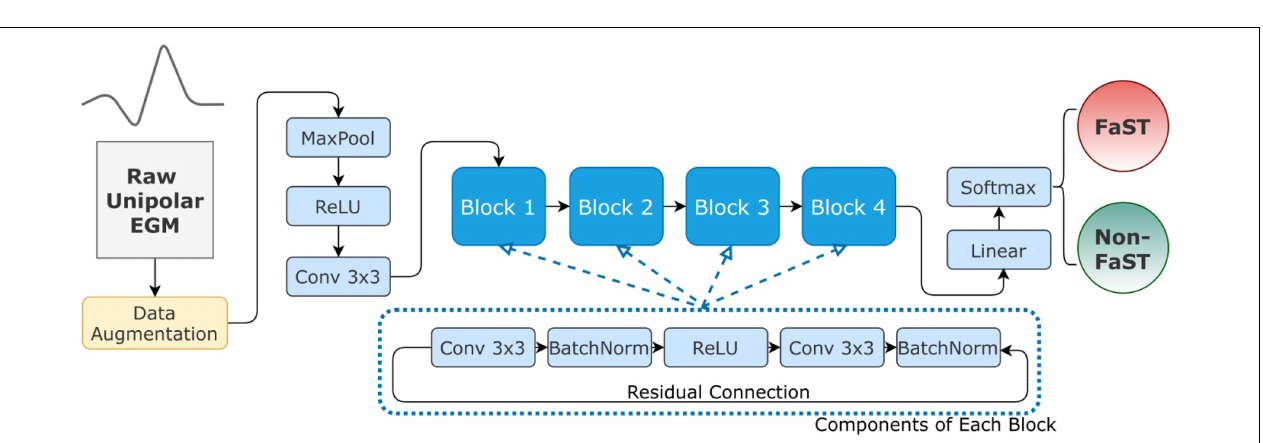
FIGURE 2 | Convolutional Neural Network Architecture. The DL model inputs raw unipolar EGM (right) and outputs a binary decision as FaST vs. non-FaST (left) . For robust training, the raw inputs are normalized and augmented as described in the text. The architecture of the proposed network is inherited from ResNet-18, which has 4 residual blocks. Each block consists of 2 convolutional, 2 batch normalization, and one ReLU layers. Abbreviations: Conv – convolutional layer, MaxPool – 1-D max-pooling